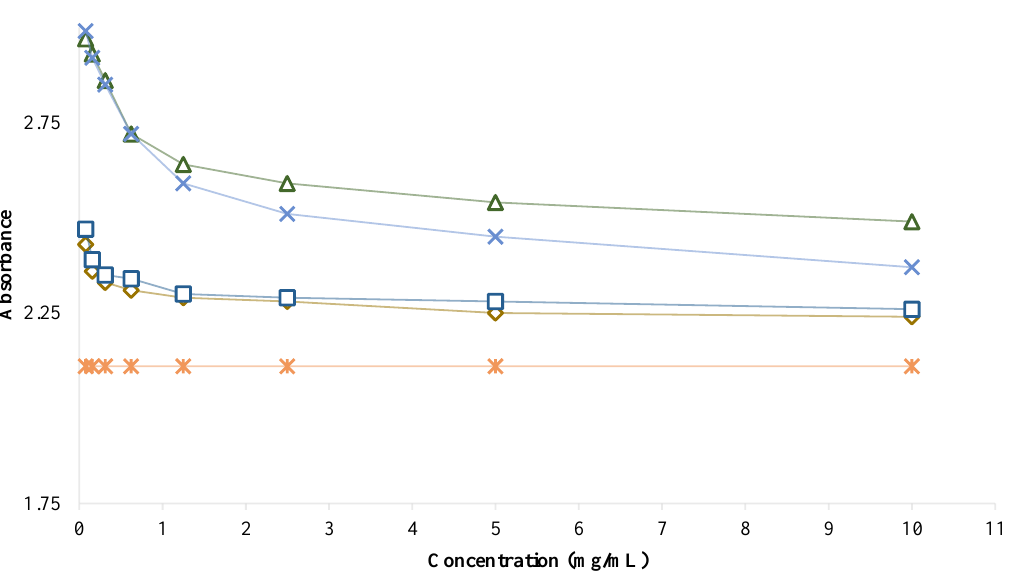
Figure 3. The impact of the tested extracts and usnic acid on the metabolic activity of P. aeruginosa biofilm.